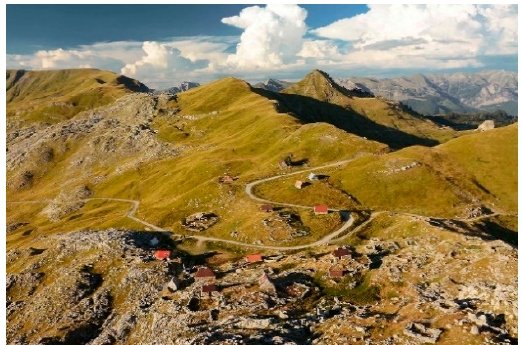
Figure 5. Katun on the slope—Širokar Ljakovi ć a, photo: I. Lakovi ć .